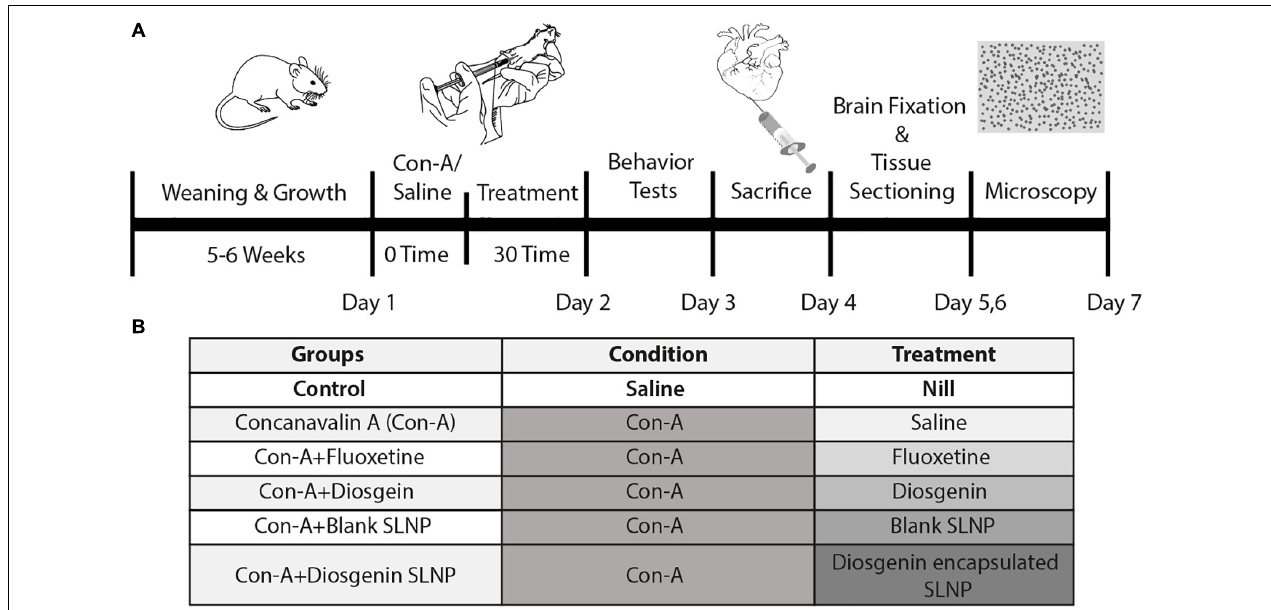
FIGURE 2 | (A) Seven-day schematic schedule of BALB/c mice model of sickness behavior and treatment. Five groups of 8-week-old BALB/c mice were exposed to Con-A (10 mg/kg body weight) to induce sickness behavior followed by subsequent pharmacological treatment. Behavior tests were performed on day 2 followed by histopathological analysis of the brain sections. (B) Grouping of mice was done on the basis of pharmacological treatment. Control group was given IP injection of saline (10 ml/kg body weight). The rest of the groups were injected with Con-A and after 30 min were treated with respective pharmacological treatments of